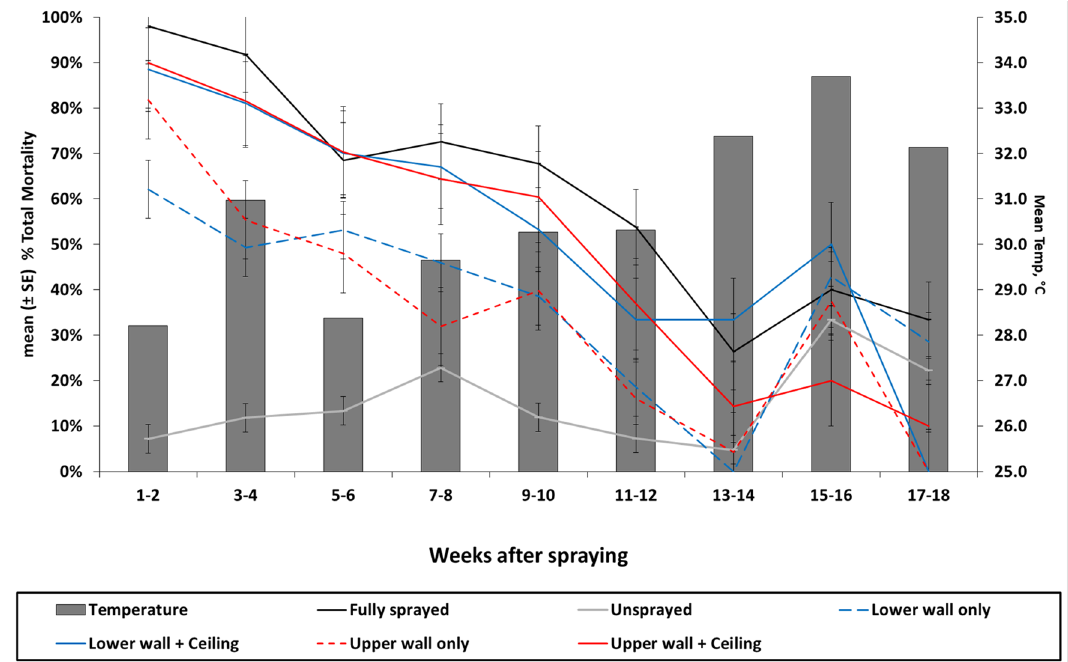
Figure 2. Anopheles gambiae s.l. mean total mortality in experimental huts with different IRS scenarios up to 18 weeks post-intervention. Post-spray mosquito mortality decreased gradually for fully and partially sprayed treatment scenarios and the rate of decrease was consistent over time. Mosquito mortality in experimental huts where upper wall + ceiling (solid red line) or lower wall + ceiling (solid blue line) was not significantly different to that observed in fully sprayed huts (solid black line), whereas spraying only the upper walls (dashed red line) or lower walls (dashed blue line) resulted in significantly lower mosquito mortality. Mosquito mortality in untreated huts (solid gray line) was consistently low throughout the study. A spike in mortality was observed across all treatments in weeks 15–16, during which the mean weekly temperature (gray bars) in experimental huts shown also